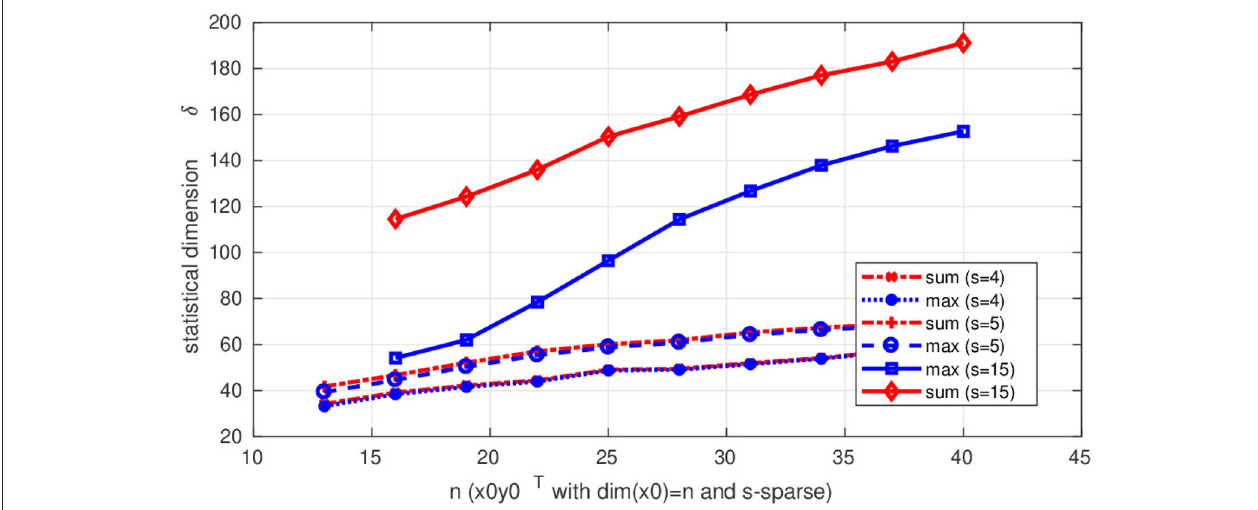
n rank-one and s s –sparse matrices M n × n 1, s , s for s × ×